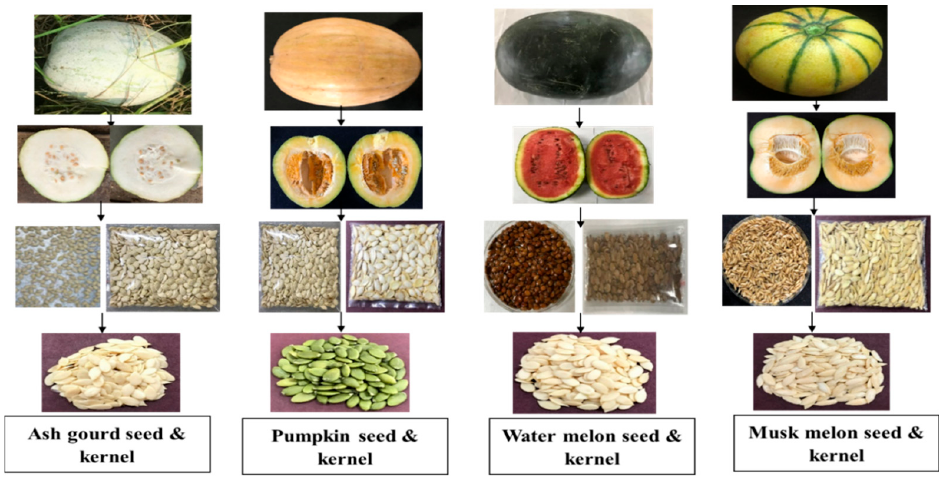
Figure 1. Preparation of seed samples.